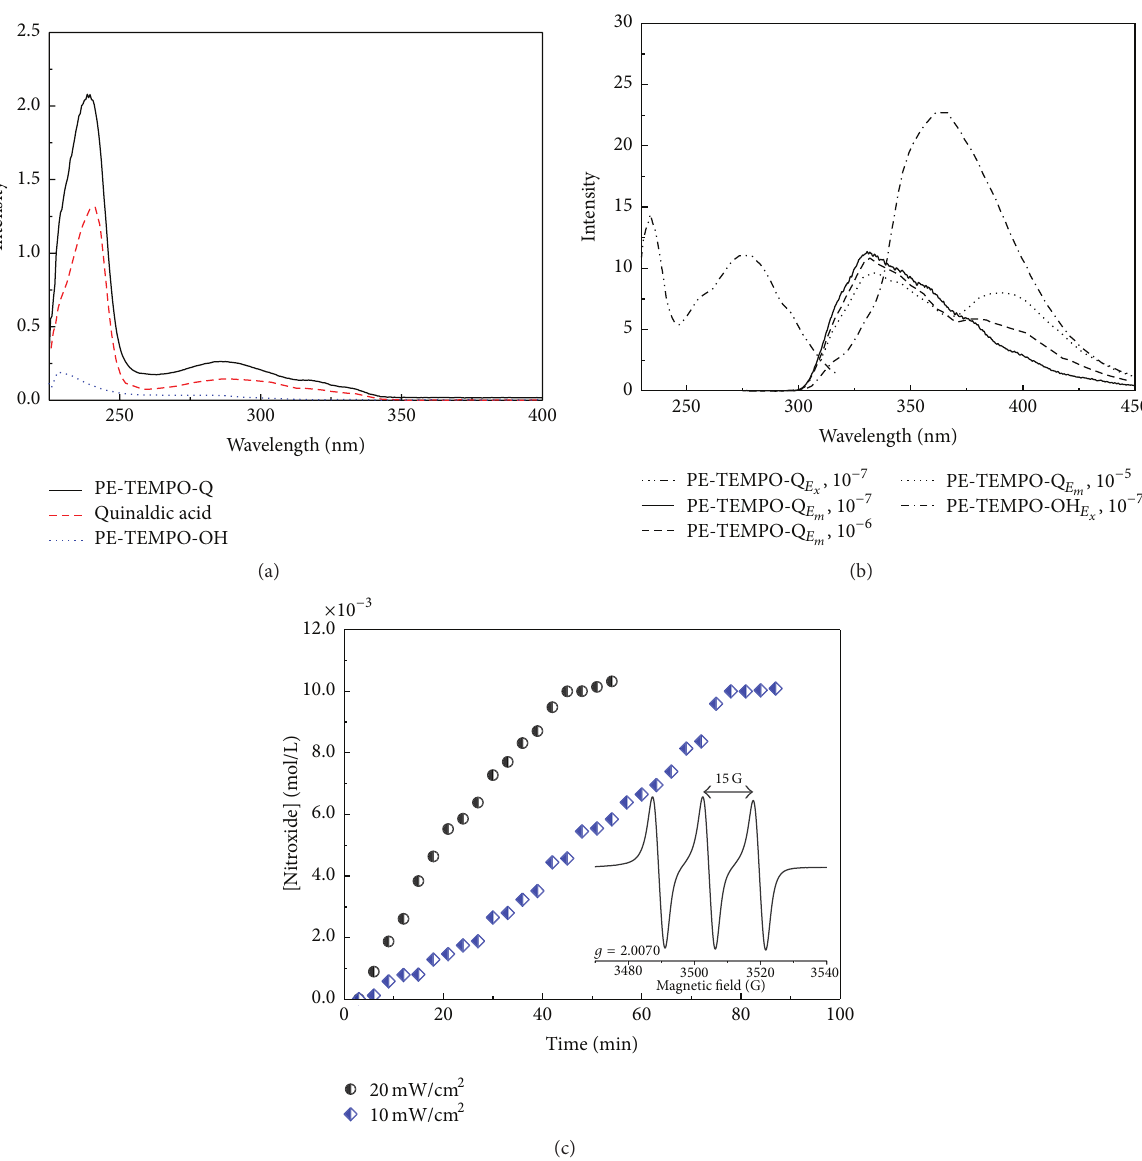
Figure 3: (a) UV absorption spectra. (b) Fluorescence spectra, 𝐸 𝑥 = excitation spectrum, and 𝐸 𝑚 = emission spectrum. (c) Plot of nitroxide concentration versus irradiation time under inert atmosphere, initial concentration of PE-TEMPO-Q is 10 −2 mol/L; the inset shows the EPR spectrum of obtained nitroxide after photolysis at 60min at 20mW/cm 2